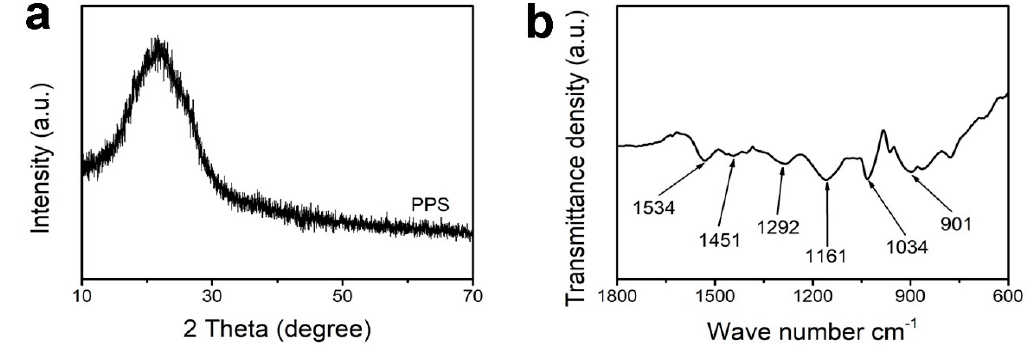
Figure 2. ( a ) XRD pattern and ( b ) FT-IR spectrum of PPS.